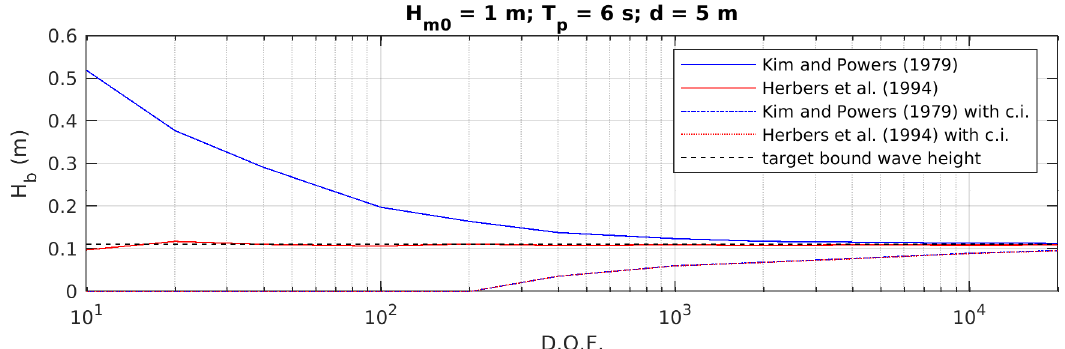
Figure A1. Calculated bound wave height using KP79 (Equation (15); blue line), HEG94 (Equation (18); red line), KP79 with confidence interval (Equation (15); blue dashed-dotted line), and HEG94 with confidence interval (Equation (18); red dotted line) as a function of the number of degrees of freedom. Note that the blue dashed-dotted and red dotted line are on top of each other. The black dashed line represents the a priori bound wave